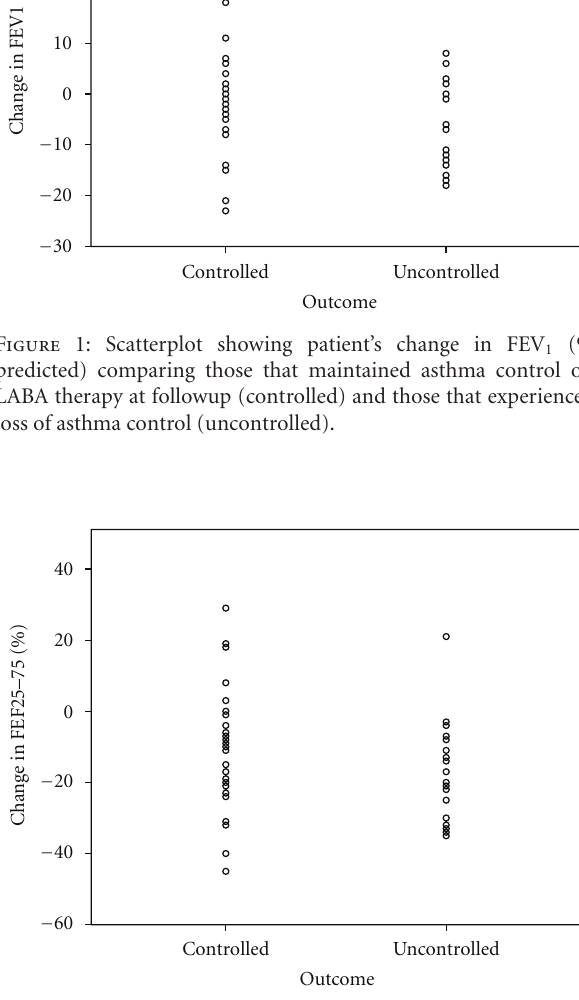
Figure 2: Scatterplot showing patient’s change in FEF 25–75 (% predicted) comparing those that maintained asthma control o ff LABA therapy at followup (controlled) and those that experienced loss of asthma control (uncontrolled).